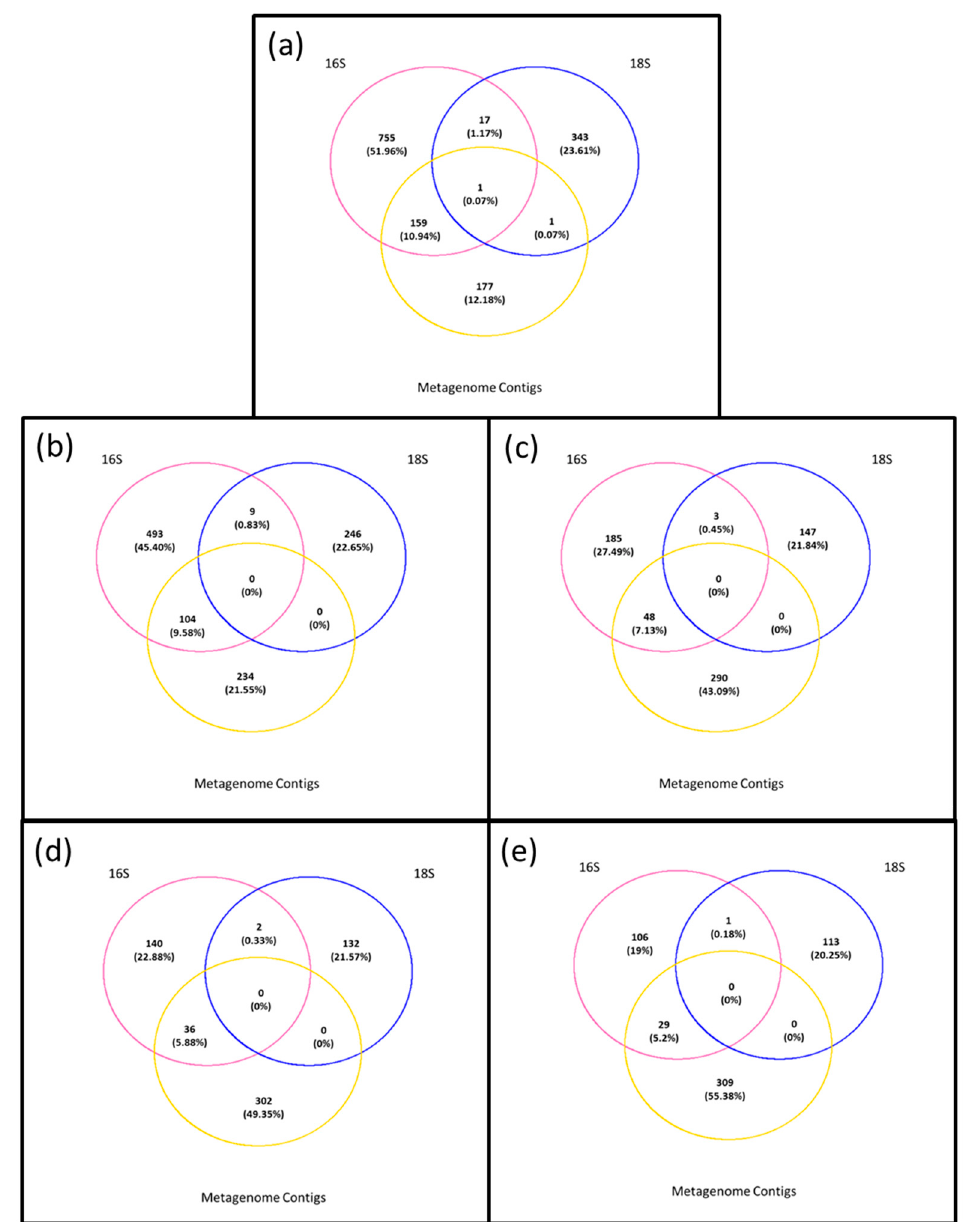
Figure 7. Presence–absence analyses between the >0.45 µ m fraction (prokaryotes and eukaryotes) and the permeate (<0.45 µ m). ( a ) T0: Metagenomic contigs, prokaryotes, eukaryotes; ( b ) T0: Metagenomic contigs, T1: prokaryotes, eukaryotes; ( c ) T0: Metagenomic contigs, T10: prokaryotes, eukaryotes; ( d ) T0: Metagenomic contigs, T10-R1: prokaryotes, eukaryotes; ( e ) T0: Metagenomic contigs, T10-R2: prokaryotes, eukaryotes.